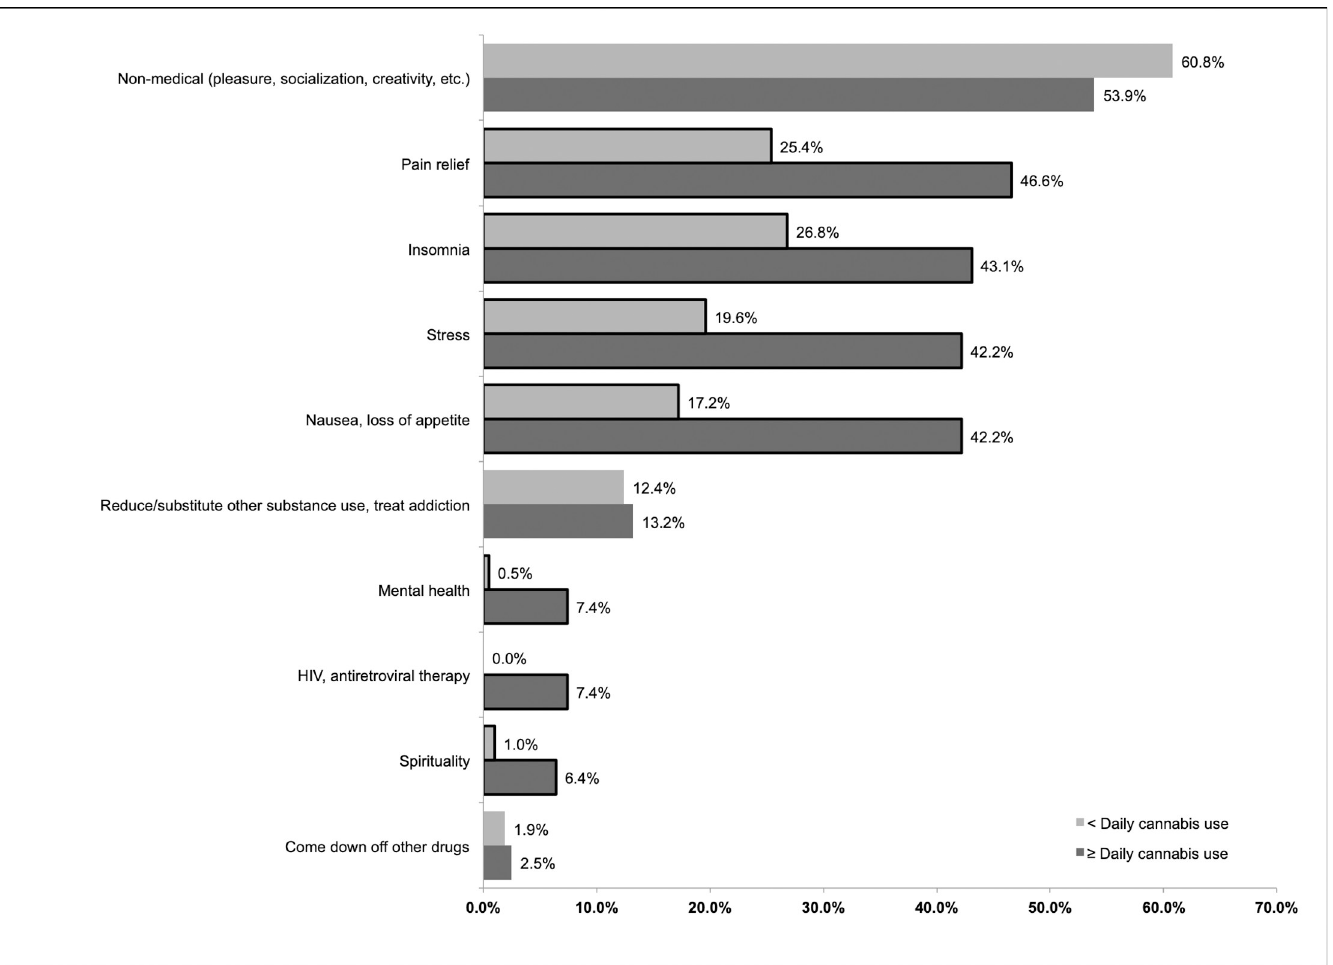
Fig 1. Self-reported reasons for cannabis use among daily ( n = 204) and occasional ( n = 210) cannabis-using people who use drugs with chronic pain, June– December 2017. Borders indicate chi-squared or Fisher’s test p < 0.05 (Fisher’s test used for mental health and HIV comparisons).